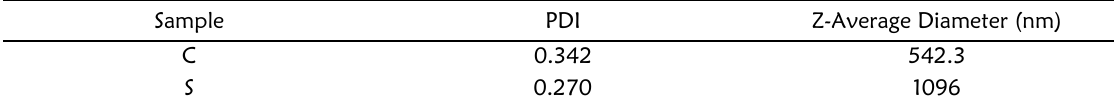
Table 6: Polydispersity Index and Z-average of Samples